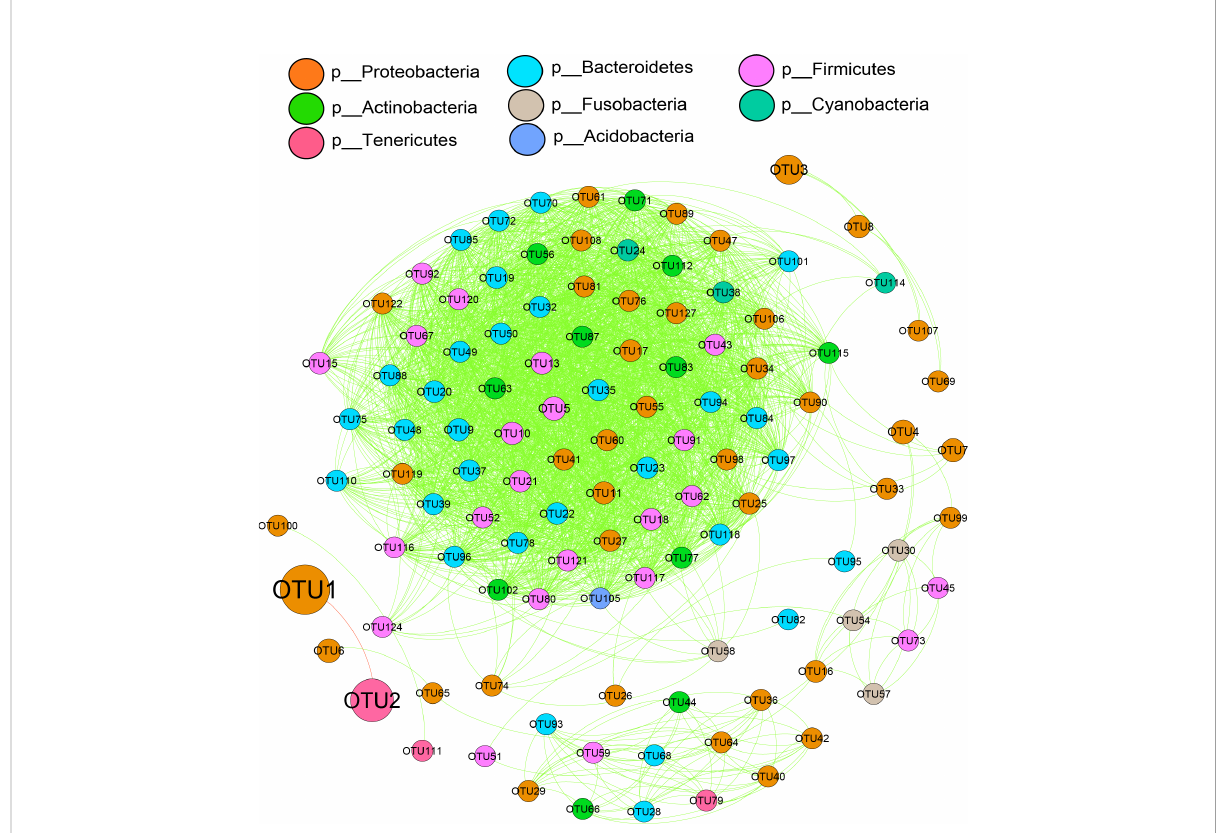
FIGURE 8 Correlation network analyses of the microbial communities of medium-form squid at the bacterial phyla level. The node size represents the abundance of each phylum. The green lines between phyla indicate a positive relationship, while the red lines indicate a negative